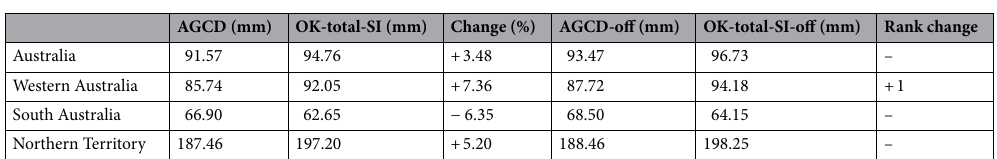
Table 1. Area-averaged totals of AGCD and OK-total-SI for December 2016. OK-total-SI-off refers to an adjustment made to OK-total-SI to make it more equivalent to the official values presented by the BOM